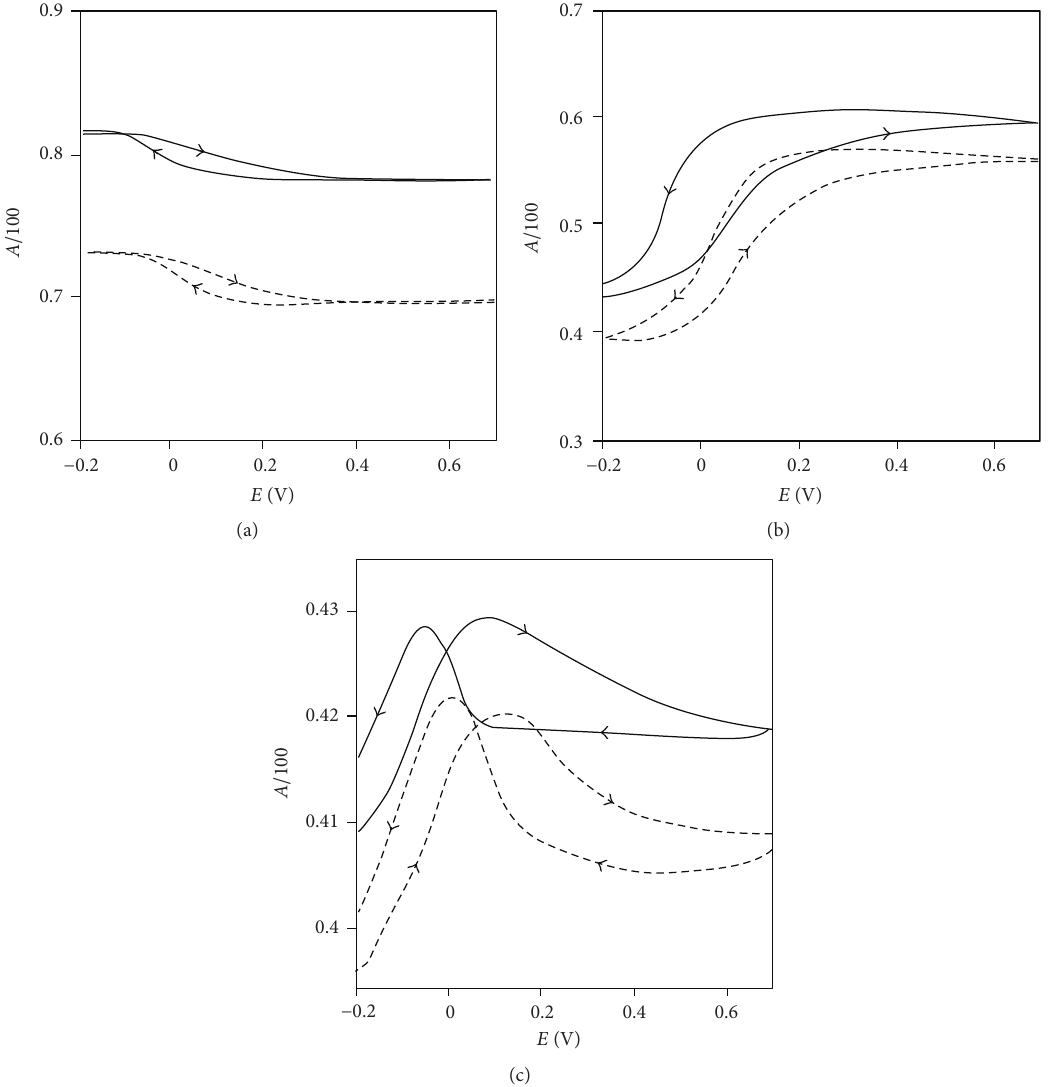
F 17: Absorbance as a function of potential at �xed (c) 750nm. e arrows indicate the potential scan direction: (- - - -) pH = 1.0 and (—) pH = 1.5. Sweep rate 0.01V